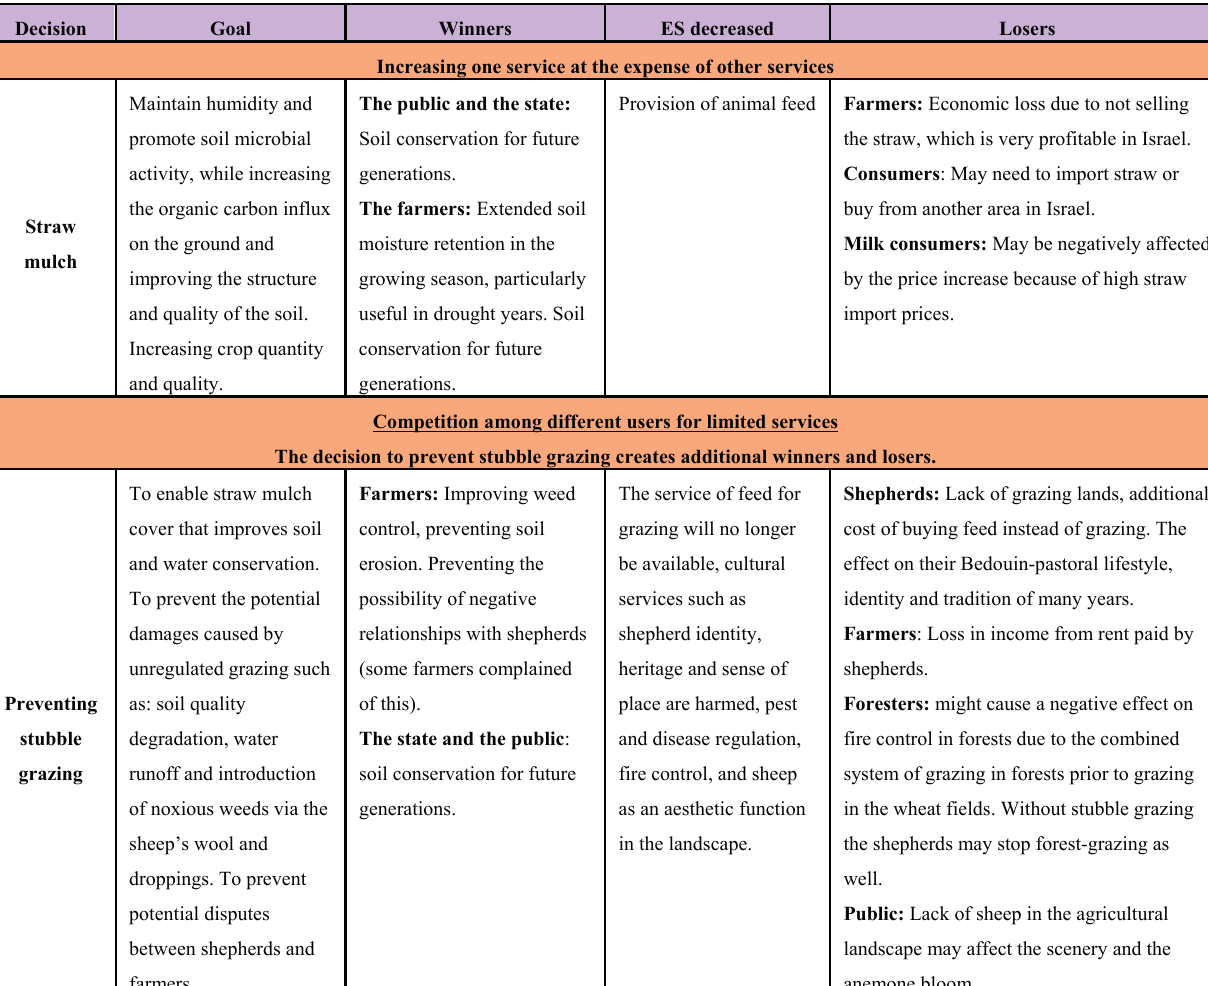
Figure 4. Rose plots showing a comparison of the impact on ecosystem service delivery of “without grazing alternative” in reference to “with grazing alternative”, based on experts’ ES assessments. Table 3. Distribution of benefits among